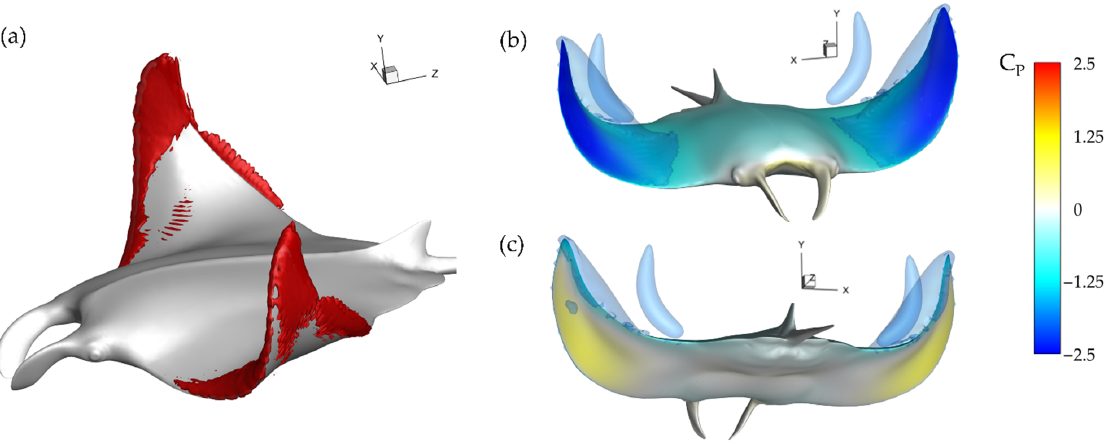
Figure 11. Case 2 (BR = 1.0 PR = 0.67) ( a ) Vorticity magnitude at half downstroke with ( b , c ) resulting surface pressure on top and bottom, respectively.